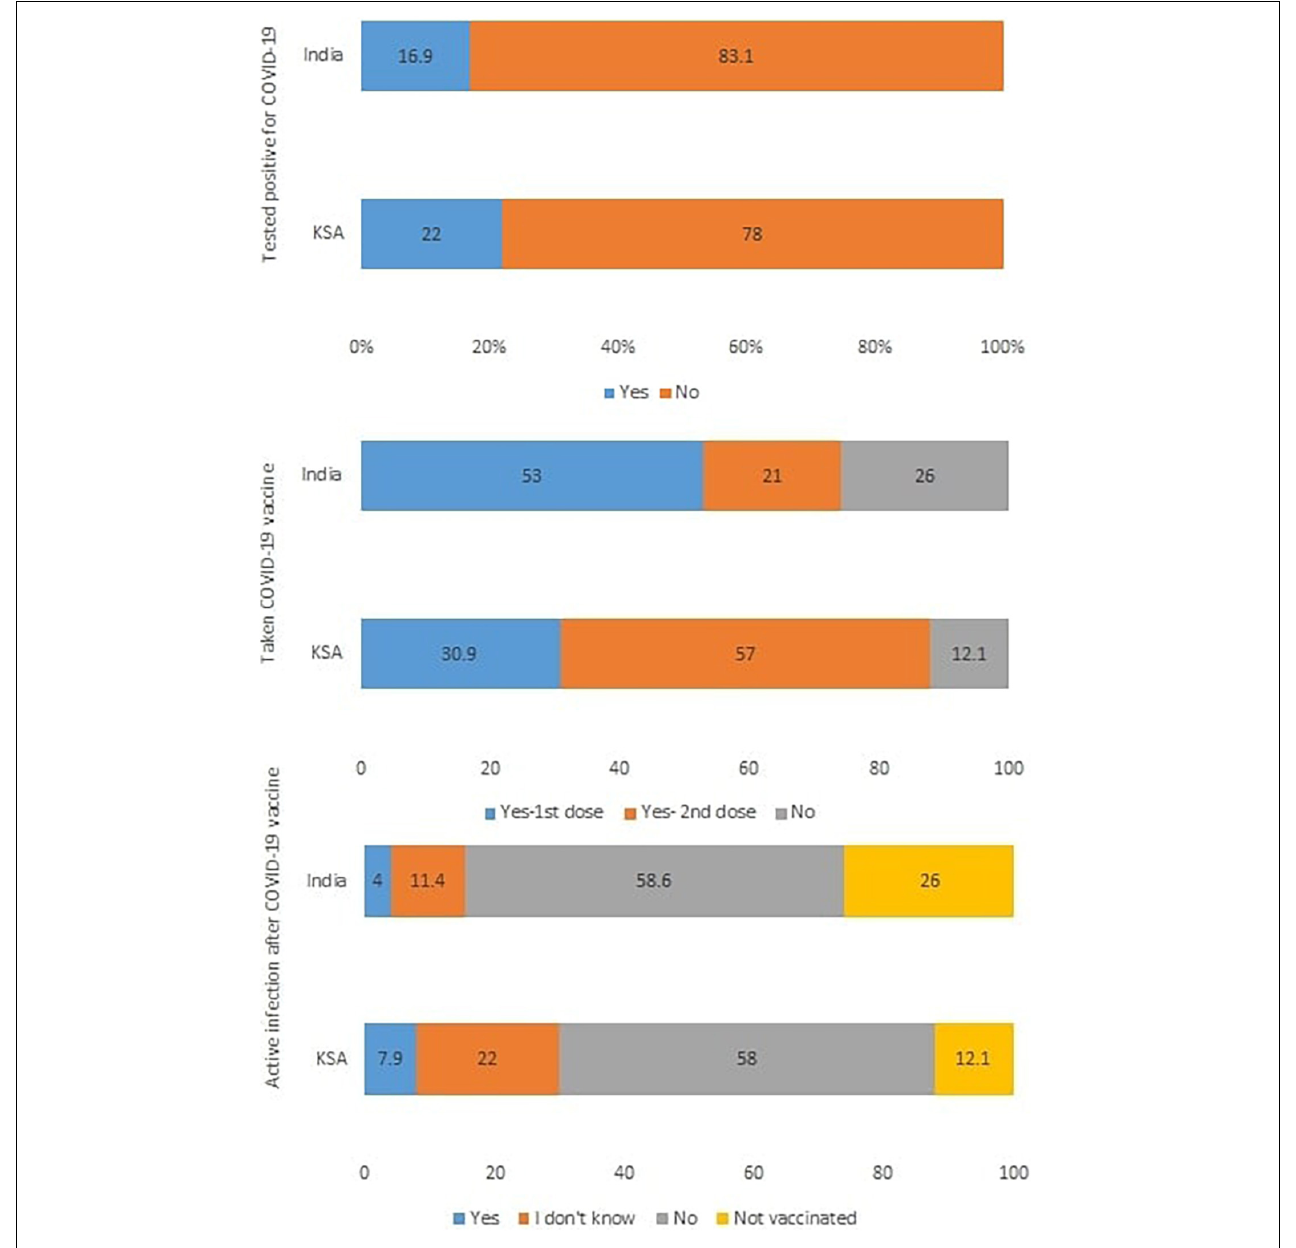
FIGURE 3 | Distribution of responses to COVID-19 status in the self-administered questionnaire (in %). KSA, Kingdom of Saudi